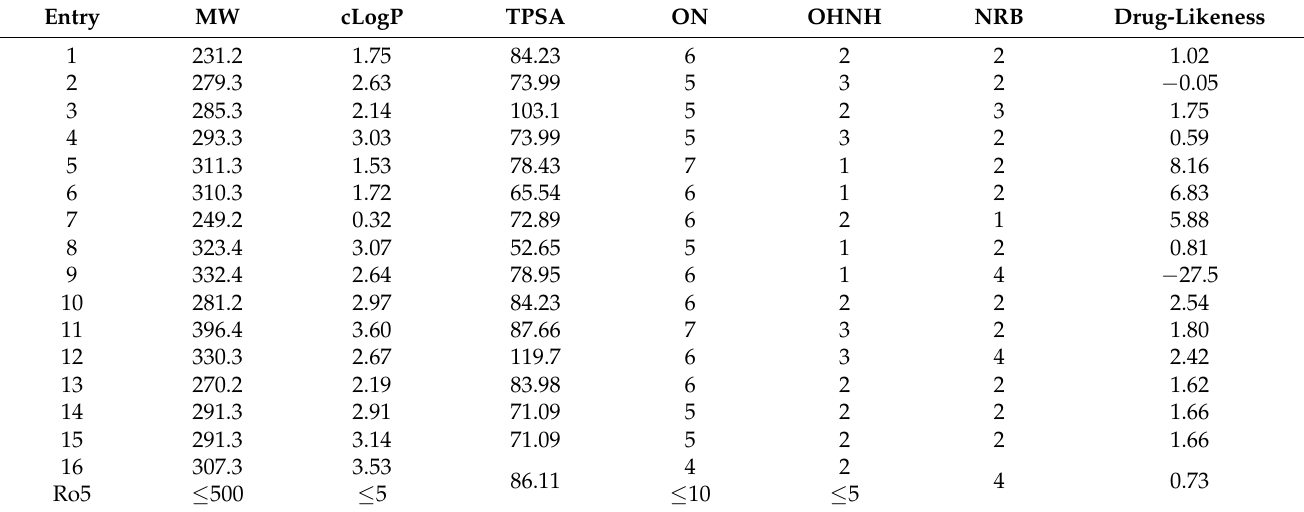
Table 2. Some Molinspiration/OSIRIS predicted pharmacokinetic properties. Calculated partition coefficients (cLogP values) were Octanol/H 2 O based.